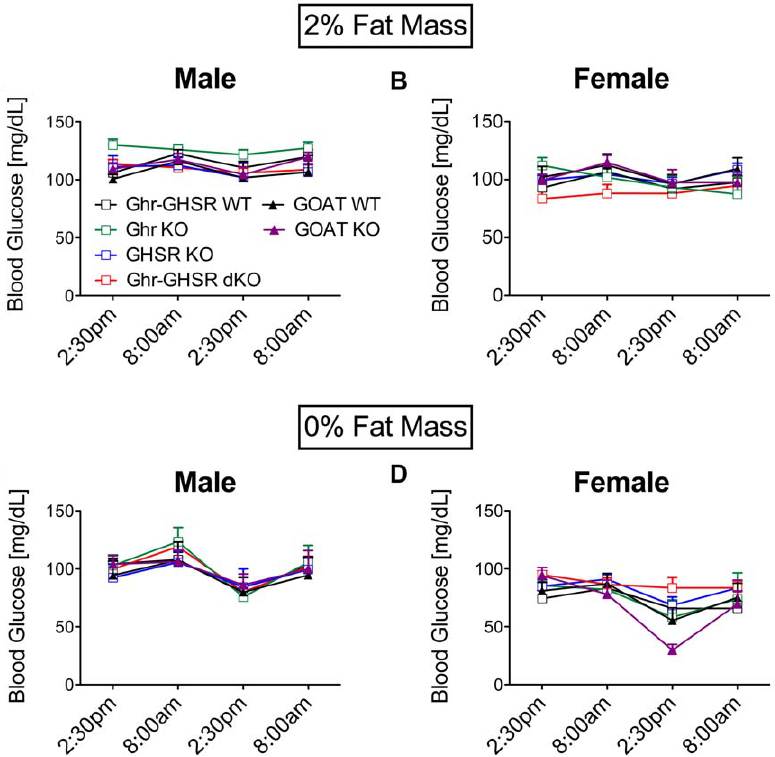
Figure 3. Stable blood glucose levels after partial or complete loss of body fat. Even after a partial (2% fat mass; A&B) or complete (0% fat mass; C&D) loss of body fat, calorie-restricted ghrelin-loss-of-function mice and their WT controls were able to maintain stable blood glucose levels. Values depict means 6 SEMs from groups of 8 male GOAT WT, 5 female GOAT WT, 9 male GOAT KO, 8 female GOAT KO, 10 male Ghr-GHSR dWT, 20 female Ghr-GHSR dWT, 19 male Ghr KO, 18 female Ghr KO, 7 male GHSR KO, 19 female GHSR KO, 16 male Ghr-GHSR dKO and 7 female Ghr-GHSR dKO mice.